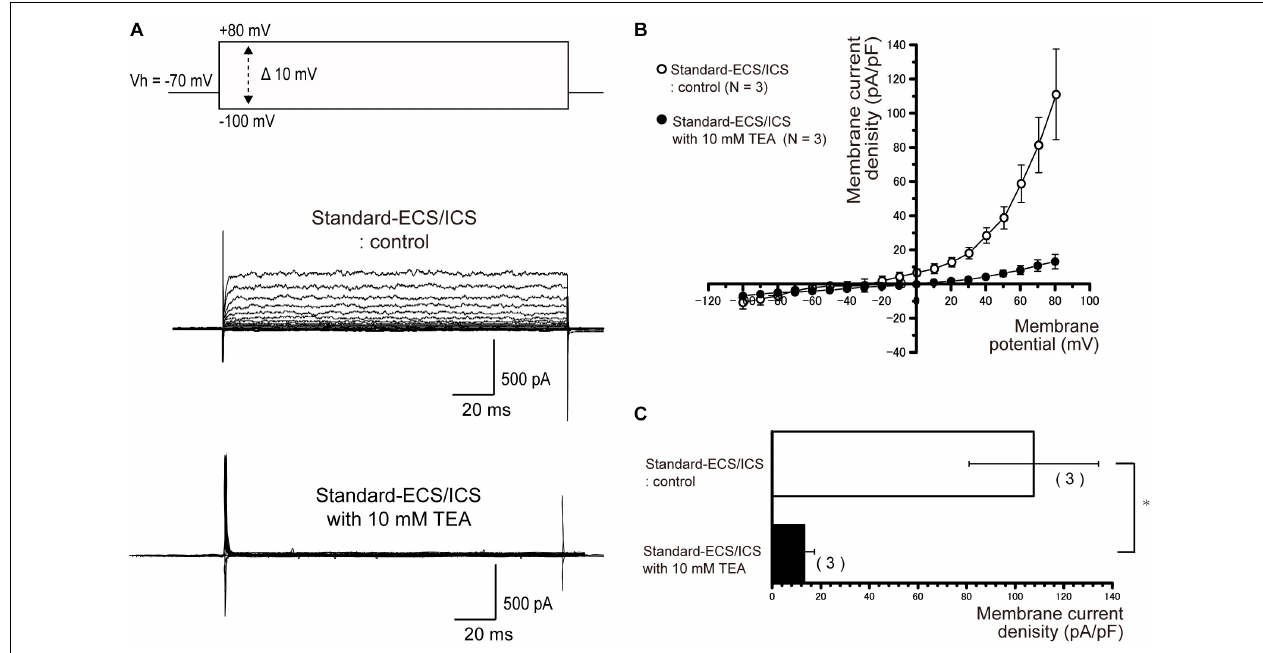
FIGURE 5 | Outward rectifying currents in human cementoblasts were TEA sensitive . (A) Representative current traces recorded under standard-ECS/ICS conditions, both without (second upper traces) and with the application of 10 mM TEA (third upper traces) are shown. Currents were evoked by applying (400 ms) voltage in 10 mV increments from –100 mV to +80 mV at a holding potential (Vh) of –70 mV (upper traces). (B) Current-voltage (I-V) relationships for the currents recorded under standard-ECS/ICS conditions without (open circles) and with the application of 10 mM TEA (filled circles) are shown. Each point represents the mean ± SE current density of three cells. (C) Summary bar graphs showing current densities under standard-ECS/ICS conditions at a membrane potential of +80 mV without (upper column) and with the application of 10 mM TEA (lower column). Columns represent the mean ± SE of three cells. Statistically significant differences are denoted by asterisks, ∗ P <